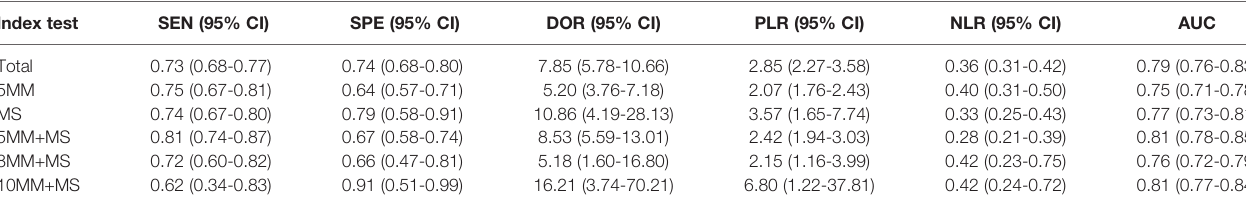
TABLE 3 | The pooled sensitivity, speci fi city, PLR, and NLR with corresponding 95% CIs for each included study under different morphological standards.